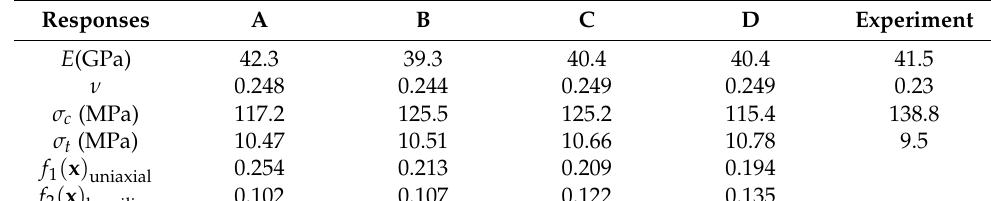
Table 6. Verification results for parameter identification.